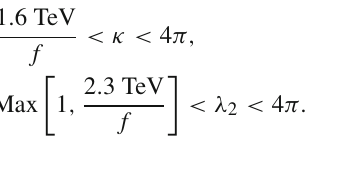
Fig. 3 Left Panel: Exclusion limits (blue region) in the ( m ψ − , m T − ) plane, using recasted limits from the CMS SUSY search of Ref. [42]. We impose the condition of Eqs. (90) and (90), assuming branching ratios of 100%. Right Panel: Exclusion limits in the ( f ,λ 2 ) plane using Ref.[42](blueregion,usingtheboundfromEq.(92)),Ref.[38](orange region) and Ref. [39] (green region)